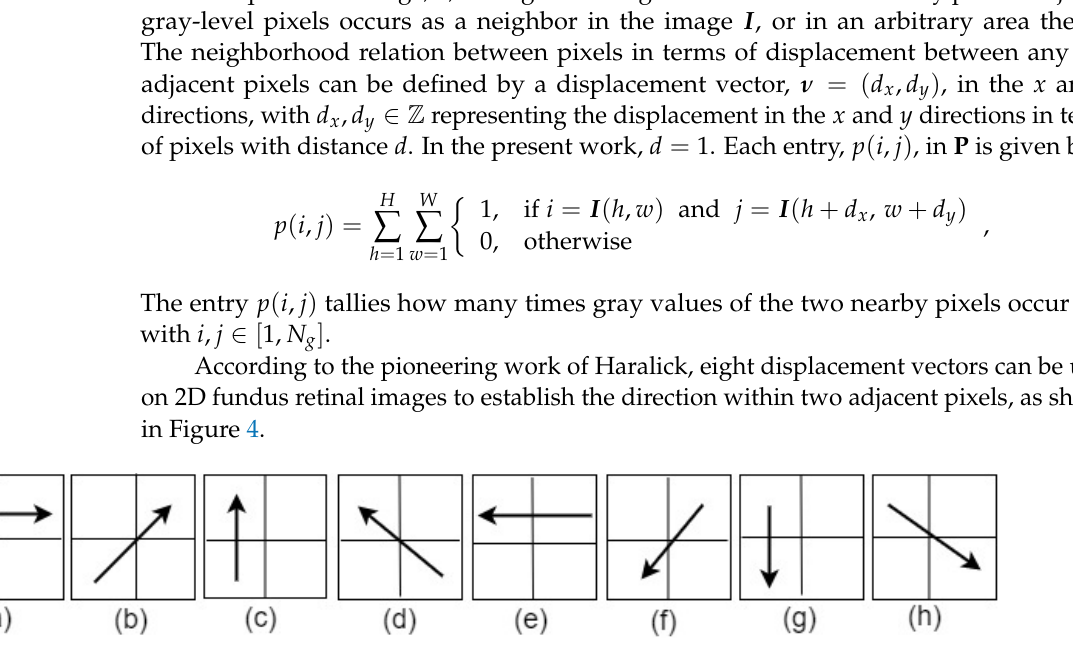
Figure 4. The eight displacement vectors that describe all possible directions of adjacency pixels. They are used to calculate the HOS features. ( a ) ν 0 ◦ = ( 1,0 ) ; ( b ) ν 45 ◦ = ( 1,1 ) ; ( c ) ν 90 ◦ = ( 0,1 ) ; ( d ) ν 135 ◦ = ( − 1,1 ) ; ( e ) ν 180 ◦ = ( − 1,0 ) ; ( f ) ν 225 ◦ = ( − 1, − 1 ) ; ( g ) ν 270 ◦ = ( 0, − 1 ) ; ( h ) ν 325 ◦ = ( 1, − 1 )